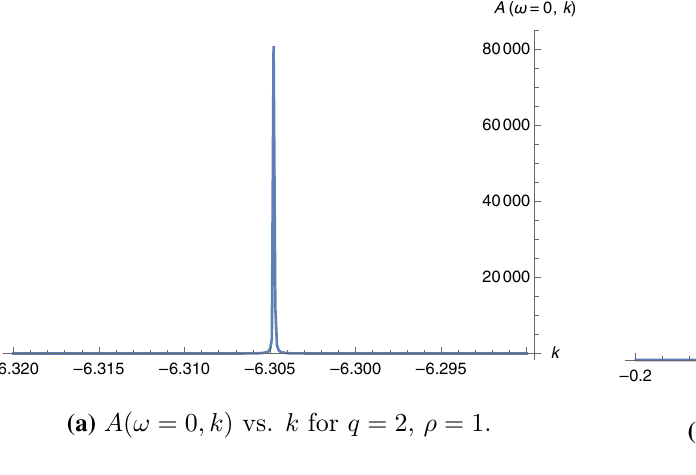
Fig. 8 A (ω, k ) vs. k and ω with q = 2, ρ =